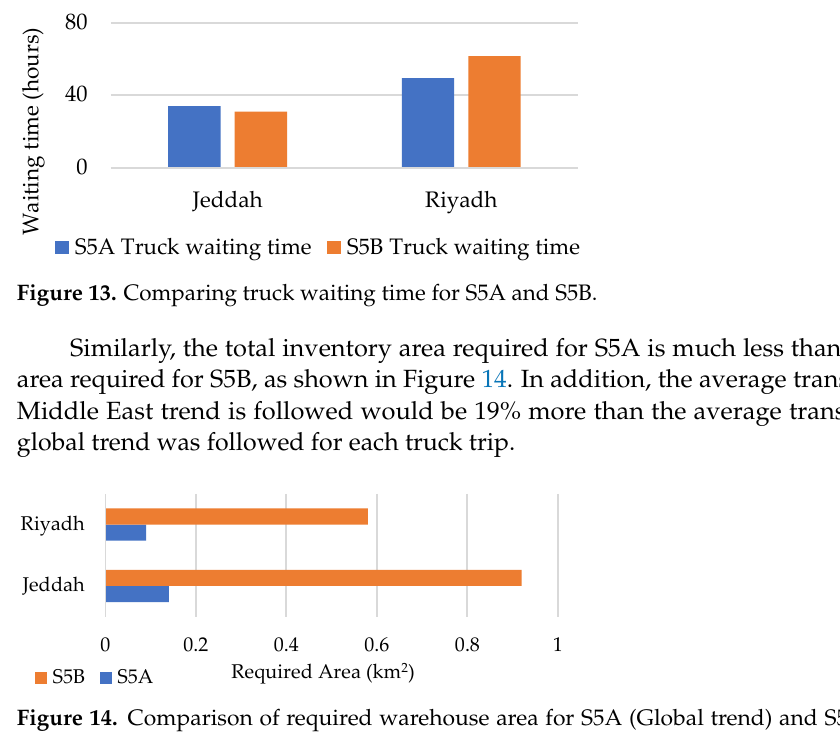
Figure 14. Comparison of required warehouse area for S5A (Global trend) and S5B (Middle East trend) (km 2 ).